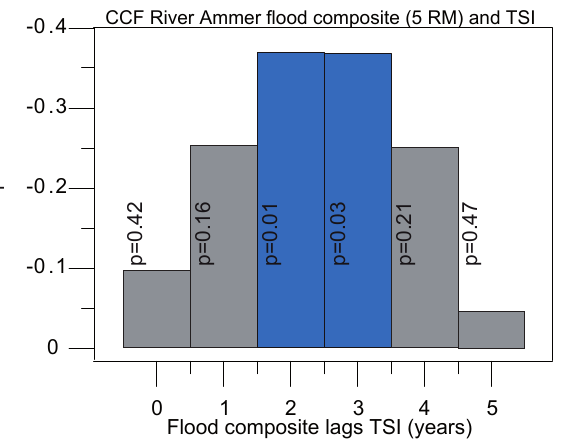
Figure 4. Cross correlation between the MJJA River Ammer flood frequency composite from the discharge record and total solar ir- radiance (TSI) (Lean, 2000) indicating significant negative correla- tions when the River Ammer flood frequency composite lags TSI by 2 to 3 years. Prior to the analysis, the River Ammer flood frequency composite was filtered with a 5-year running mean. Correlations were calculated using a random-phase test (Ebisuzaki,